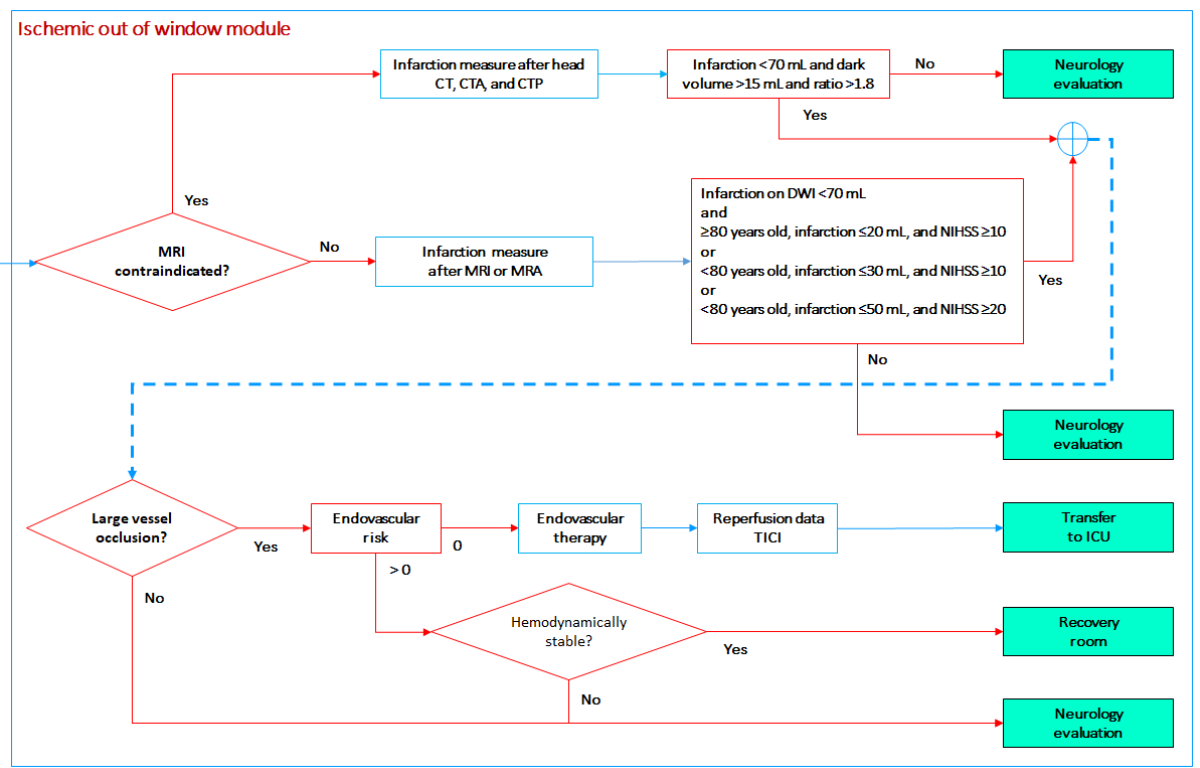
Figure 10. Ischemic stroke out of window module. CT: computed tomography; CTA: computed tomography angiography; CTP: computed tomography perfusion; DWI: diffusion-weighted magnetic resonance imaging; ICU: intensive care unit; MRA: magnetic resonance angiography; MRI: magnetic resonance imaging; NIHSS: National Institutes of Health Stroke Scale; TICI: Thrombolysis in Cerebral Infarction